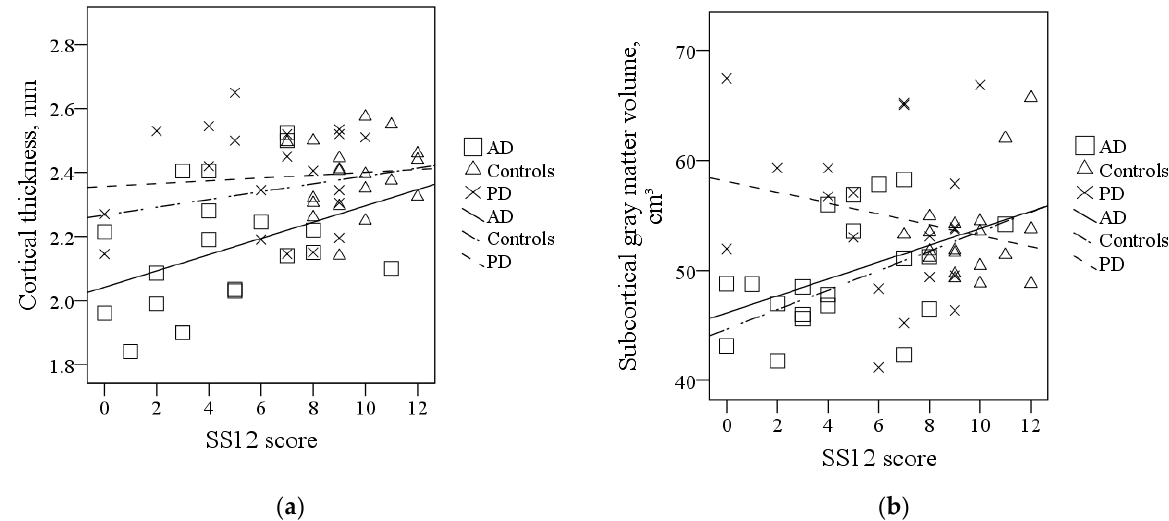
Figure 2. Correlations between SS12 scores and global gray matter morphometric measures: ( a ) Correlations between SS12 scores and cortical thickness: AD: r = 0.374, p = 0.104; PD: ρ = 0.008, p = 0.972; Controls: r = 0.166, p = 0.496; ( b ) Correlations between SS12 scores and subcortical gray matter volume: AD: r = 0.439, p = 0.053; PD: ρ = − 0.140, p = 0.556; Controls: ρ = 0.062, p = 0.802. Abbreviations : AD, Alzheimer’s disease; PD, Parkinson’s disease; SS12, Sniffin’ Sticks 12 test.